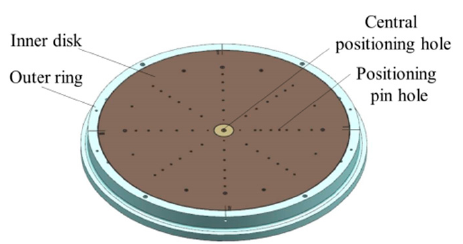
Figure 2. 3D model of the multi-station switching device.